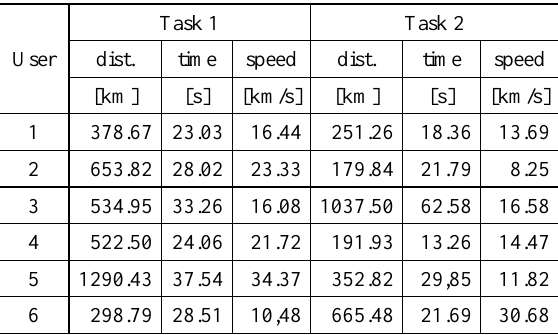
Tab. 3. Virtual distances, lengths of user performances and speeds of individual users in task 1 and